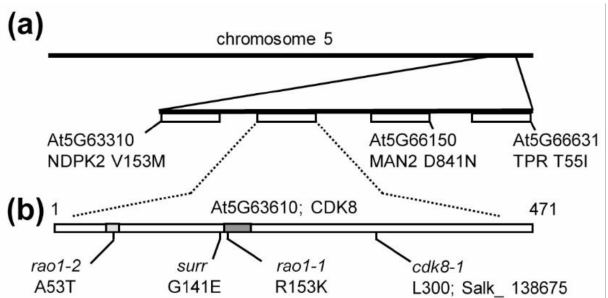
Figure 5. Identification of the surr mutation in cyclin-dependent kinase 8 ( CDK8 ). Whole-genome sequencing revealed several genetically linked mutations at the end of chromosome 5—namely, in the genes nucleotide di-kinase 2 ( NDPK2 ), cyclin-dependent kinase 8 ( CDK8 ), alpha-mannosidase 2 ( MAN2 ), and TPR ( a ). ( b ) The only mutation completely linked to the surr mutant phenotype is in cycline-dependent kinase 8 ( CDK8 , At5g63610). Previously identified CDK8 alleles used in this study and the change in amino acids of the missense alleles are indicated. Numbers refer to amino acid positions in the CDK8 protein. The ATP binding site and the kinase active site are indicated by bright and dark grey,